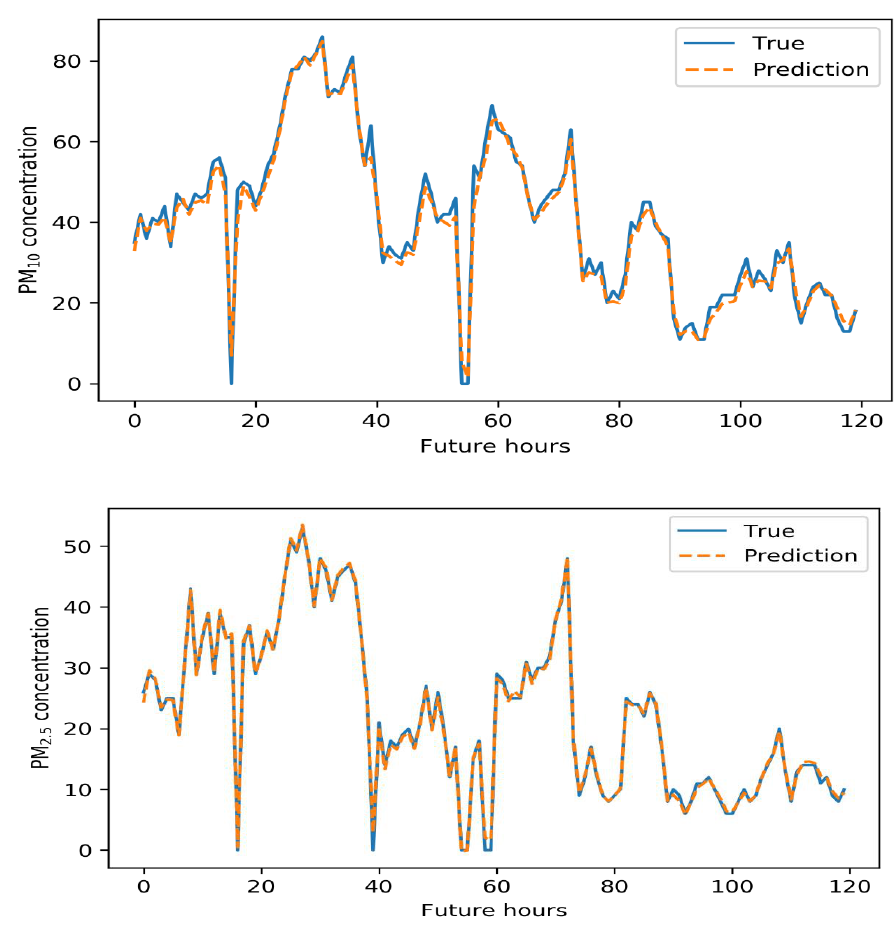
Figure 11. Five-day air pollution levels predicted by the CNN–LSTM model.